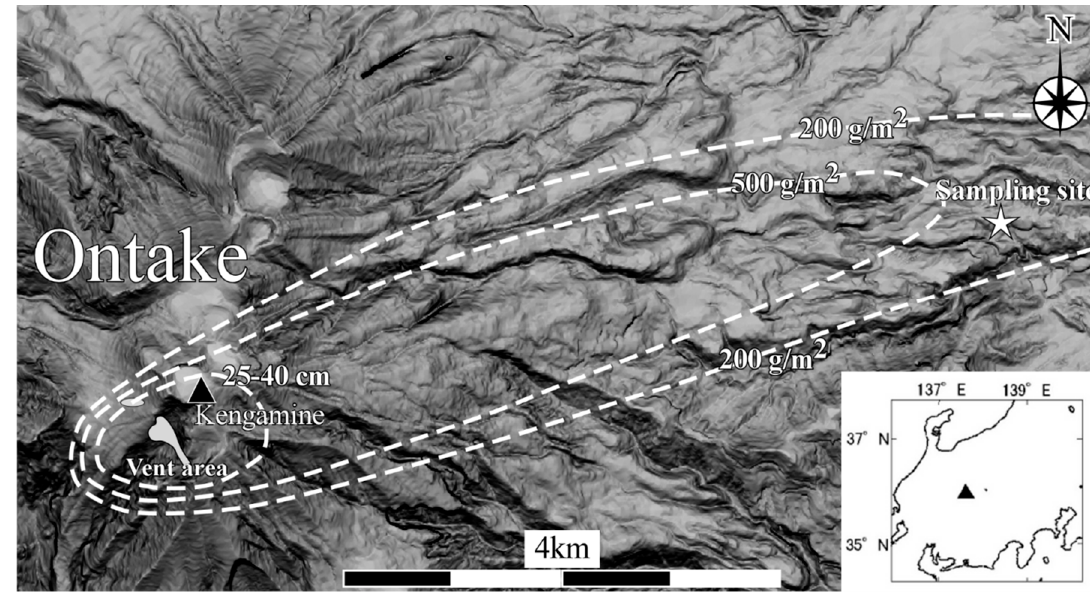
Figure 1. Sampling location of volcanic ash from the 2014 eruption. The topographical relief map is created with Kashimir3D [30] from the 10-m-mesh DEM data provided by the Geospatial Information Authority of Japan. Thickness and isomass contours of the volcanic ash from the 2014 eruption were referred from the results of the geological survey conducted by Earthquake Research Institute, The University of Tokyo (ERI) (2014) [31].